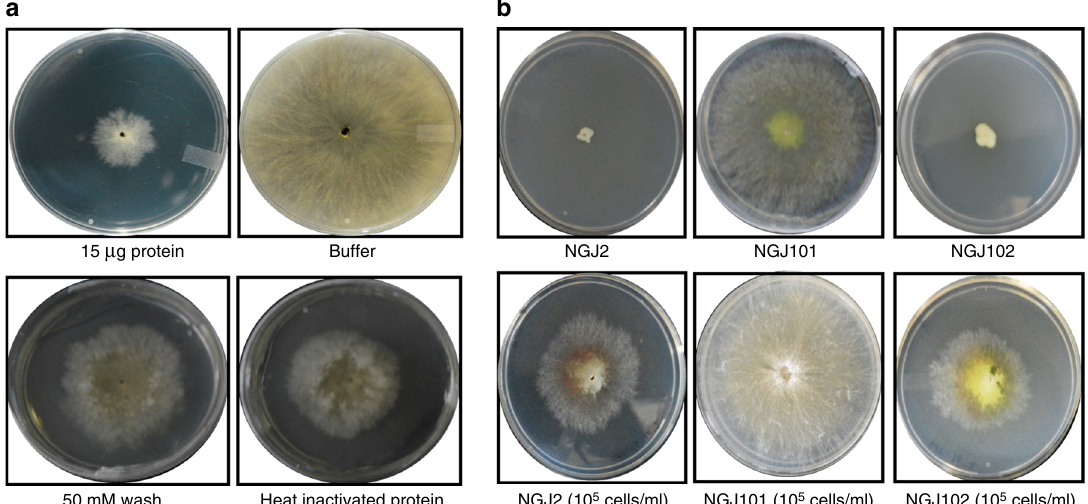
Fig. 3 A prophage tail-like protein (Bg_9562) is required for bacterial mycophagy. a Effect of Bg_9562 protein (15 µ g/ml) and various control treatments on sclerotial germination and growth of R. solani on fresh PDA plates at 48 h post treatment. The growth was found to be restricted upon protein treatment. b Effect of Bg_9562 mutant and complement on sclerotial germination and growth. The mutant (NGJ101) was defective in preventing sclerotial germination while the wild type (rif R derivative of NGJ1; NGJ2) and complement (NGJ102) were pro fi cient. Upon treatment with 10 5 cells/ml of bacterial cultures, the sclerotia could germinate initially but subsequently the NGJ2 as well as NGJ102 grew over fungal biomass while NGJ101 failed to do so. Similar results were obtained in at least three independent